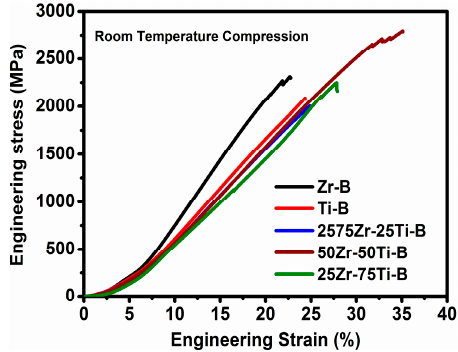
Figure 10. Room temperature compressive strength of RSPSed samples.